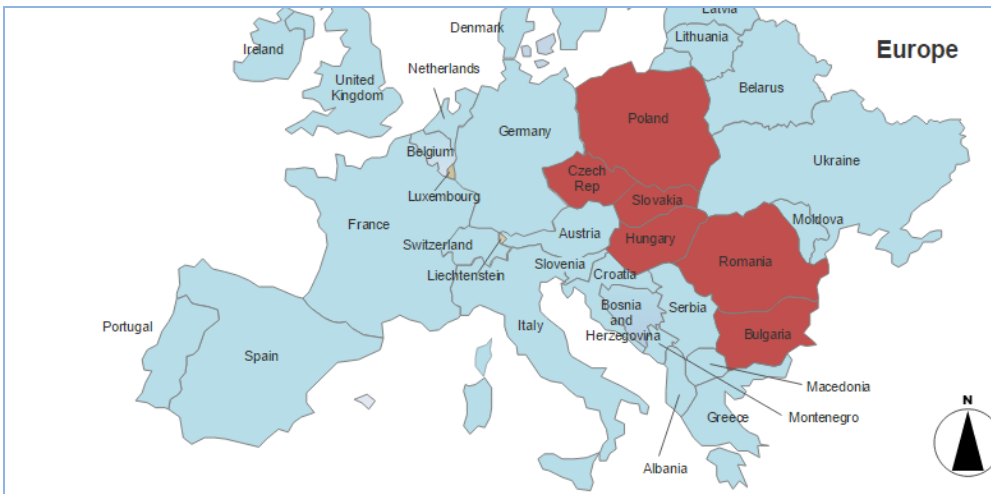
Fig. 1. Nations of Central and Eastern Europe. Red shaded; UN area code #151, Bulgaria, Czech Republic, Hungary, Poland, Romania, and Slovakia considered in the present study (Source: the